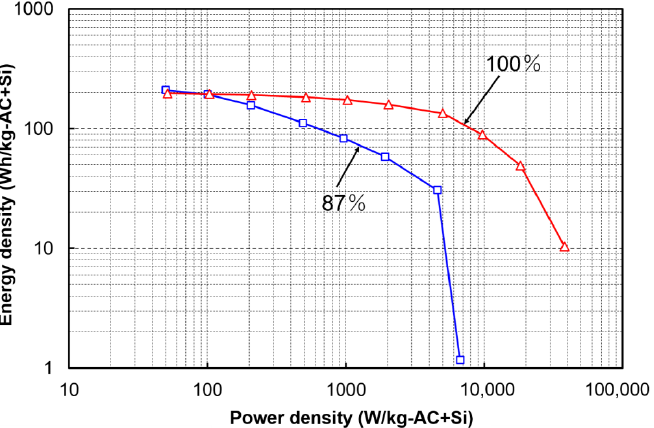
Figure 3. Ragone plots of the 100% and 87% prelithiation cells based on rate test